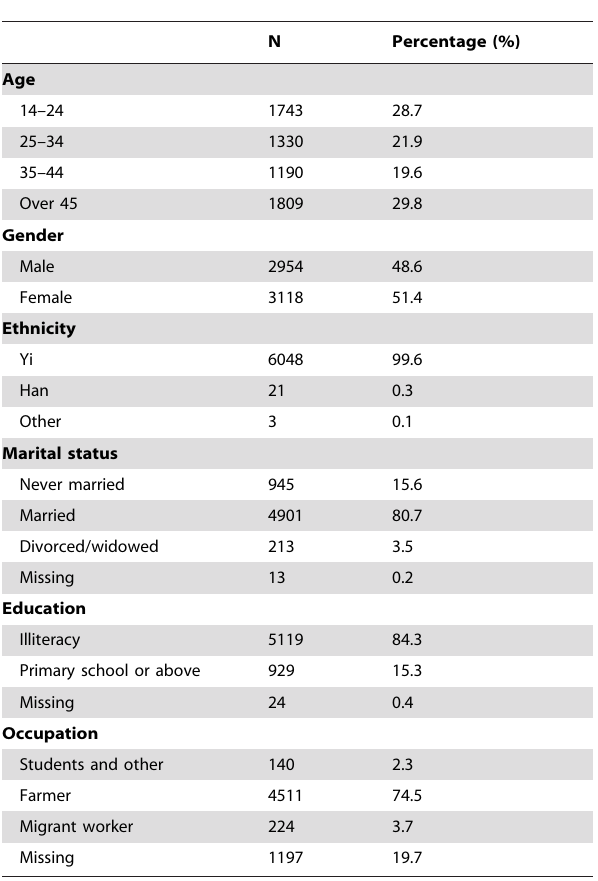
Table 1. Demographic characteristics of study